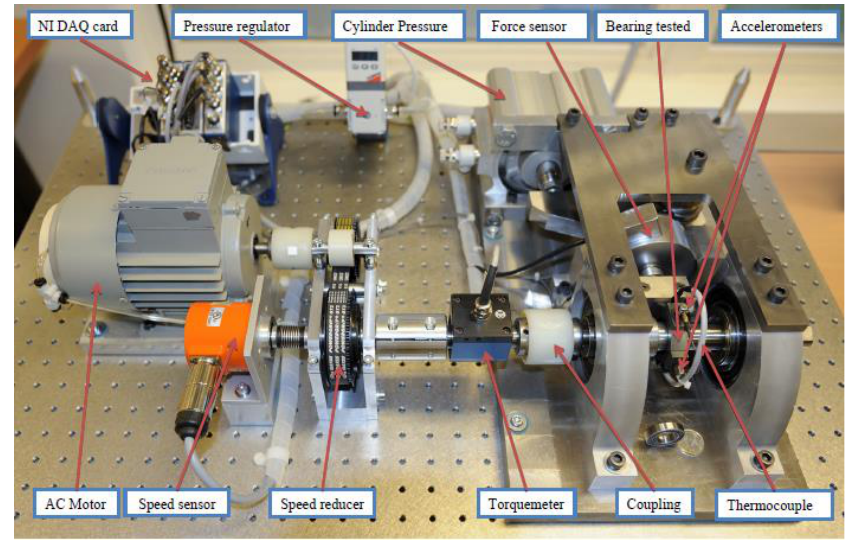
Figure 6. Aging platform PRONOSTIA.